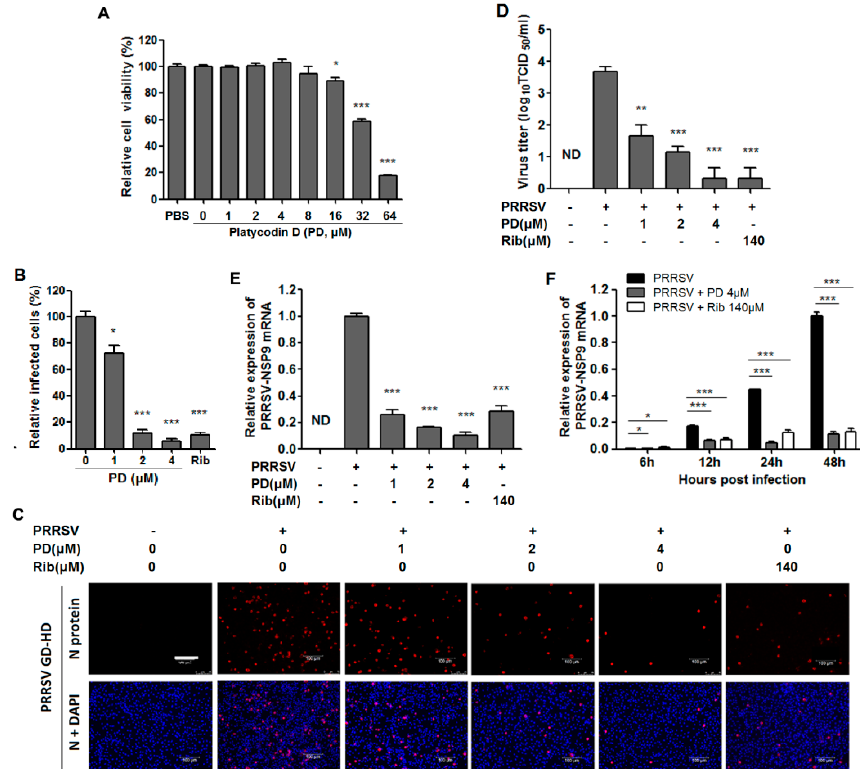
Figure 3. The anti-PRRSV activity and cellular toxicity of PD in PAM cultures. ( A ) Cellular toxicity of PD was examined in PAM cells using an MTT assay as described in the methods. ( B – F ) PAMs grown in 96-well plates ( B and C ) or 6-well plates ( D – F ) were infected with PRRSV GD-HD (0.5 MOI) for 2 h at 37°C and then treated with PD at various concentrations. Twenty-four hours or indicated time later, the samples were studied by IFA, or viral titer or RT-PCR analysis. ( B and C ) IFA for the N protein of PRRSV was performed at 24 hpi using Alexa Fluor 568-conjugated goat anti-mouse antibody as the secondary antibody (red), and nuclei were stained with DAPI (blue). Scale bar: 100 μ m. Results shown in ( B) are the mean values of percentages of PRRSV-infected cell ratio in PD-treated groups compared to the DMSO-treated control (0 μ M PD, set as 100%) from three independent IFA experiments, and ( C) is one representative IFA data from ( B) . ( D ) The PRRSV titer was determined after treatment with PD for 24 h using the end point dilution assay and expressed as log 10 TCID 50 /1 mL. ( E and F ) Relative PRRSV NSP9 mRNA expression of PD treated groups to DMSO-treated control (set as 1) was analyzed using real-time RT-PCR at 24 h ( E ) or indicated time-points ( F ) post PD treatment. * p < 0.05, ** p < 0.01, and *** p < 0.001 compared to DMSO-treated control.